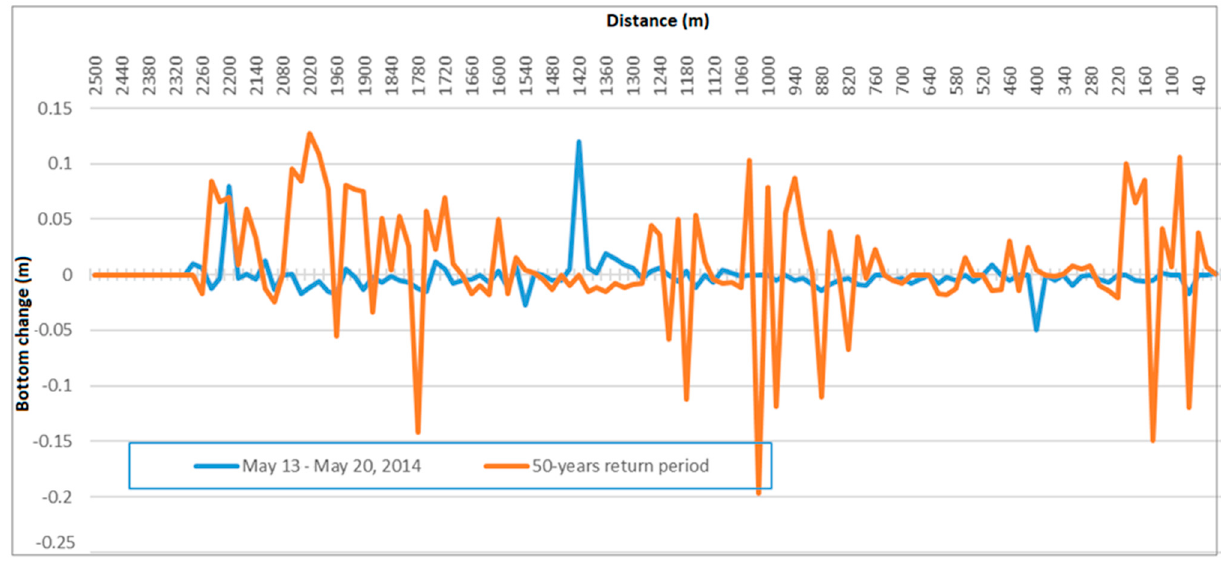
Figure 9. Longitudinal change of bottom in the period May 13 to May 20, 2014 and design precipitation episode of the 50-year return period.